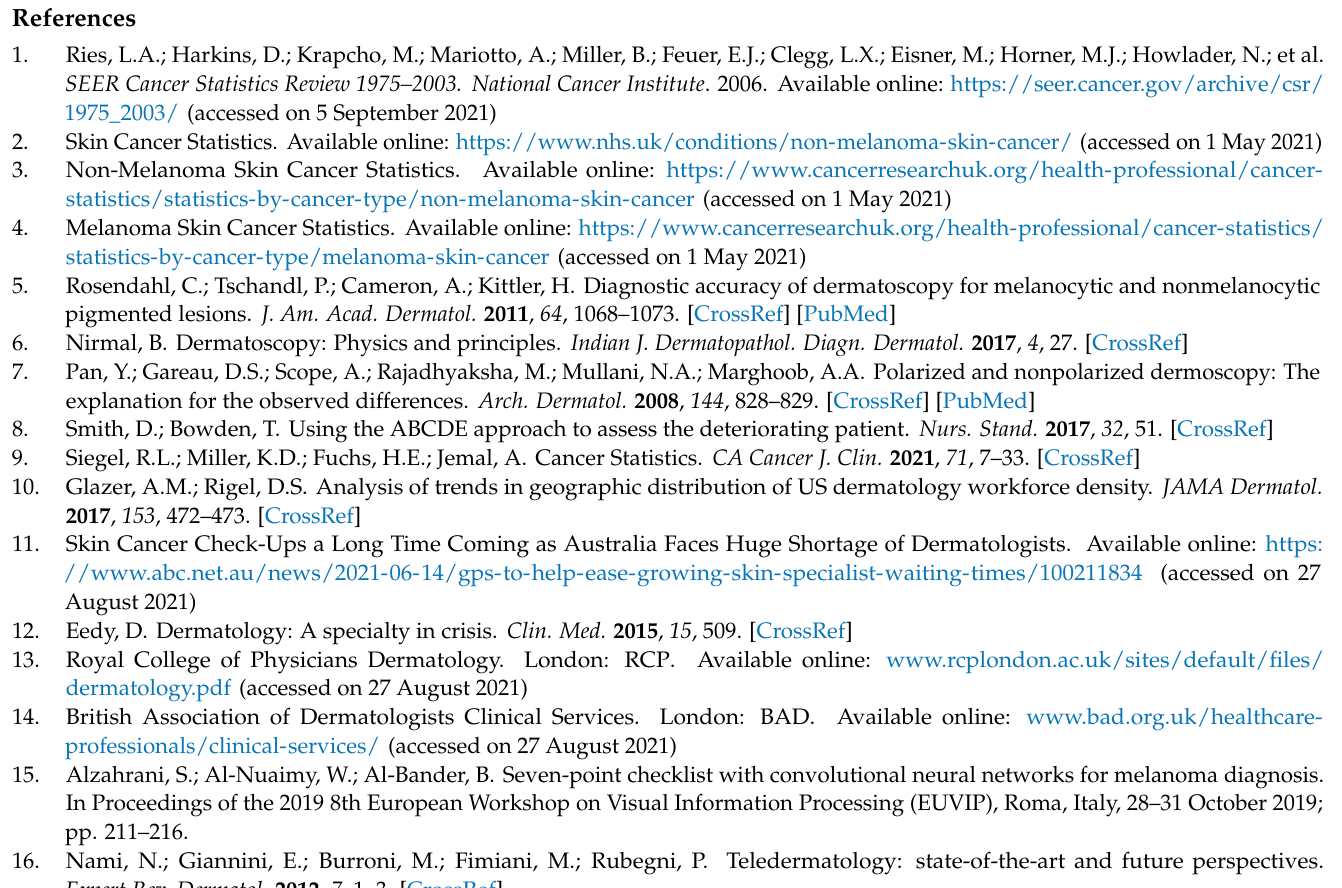
Figure A1. The performance of the CNN models visualizing training, validation and loss